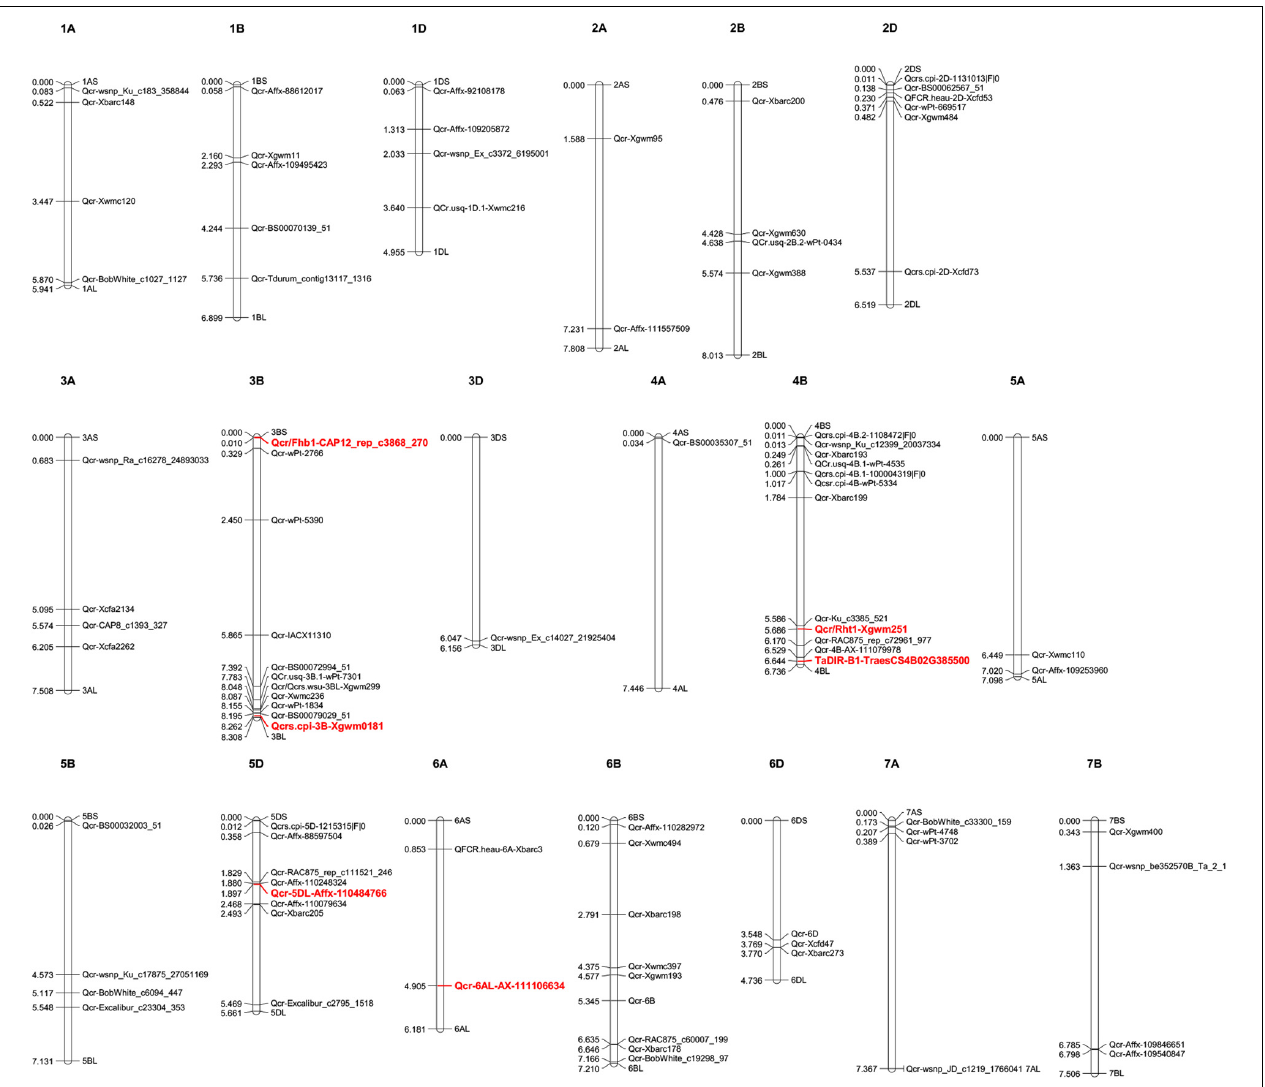
FIGURE 3 | Genetic loci controlling wheat resistance to Fusarium crown rot. Molecular markers, SNPs, and genes associated with FCR-resistant QTLs were collected from previous publications and searched against the JBrowse-1.12.3-release of the common wheat “Chinese Spring” genome available from the “ Triticeae Multi-omics Center (http://202.194.139.32/).” Physical positions (numbers indicated on the left side of each chromosome, in units of 100,000,000 bp) were used to generate a distribution map of all the collected QTLs using Mapchart v2.32 software. Stable QTLs with large effect or linked with designated genes are highlighted in red. Detailed information for these QTLs can be found in Table 2